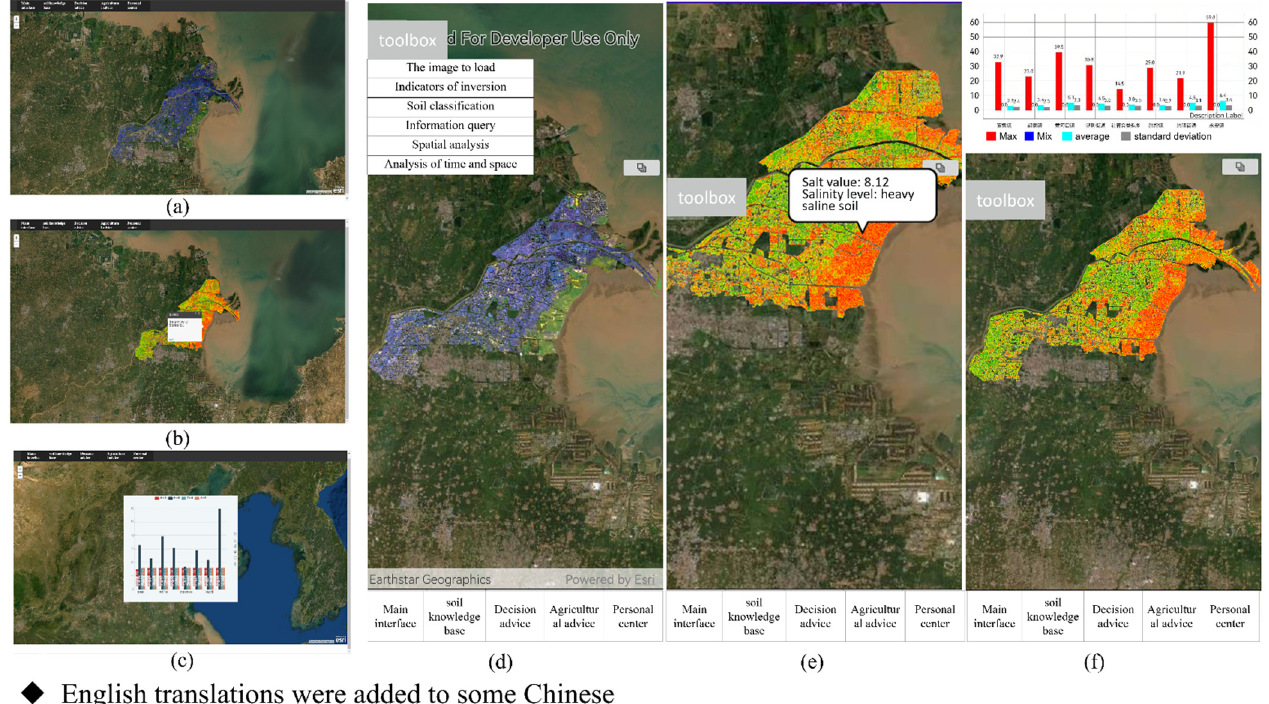
Figure 6. Intelligent inversion and spatial distribution of soil salinity in Kenli District, Yellow River Delta. ( a ) The Web client loads the image; ( b ) The Web client inverse grading; ( c ) The Web client spatial analysis; ( d ) The Mobile APP loads the image; ( e ) The Mobile app inversion and query; ( f ) The Mobile APP hierarchical analysis. Table 3. Statistical results of soil salinity classification in Kenli District, Yellow River Delta.